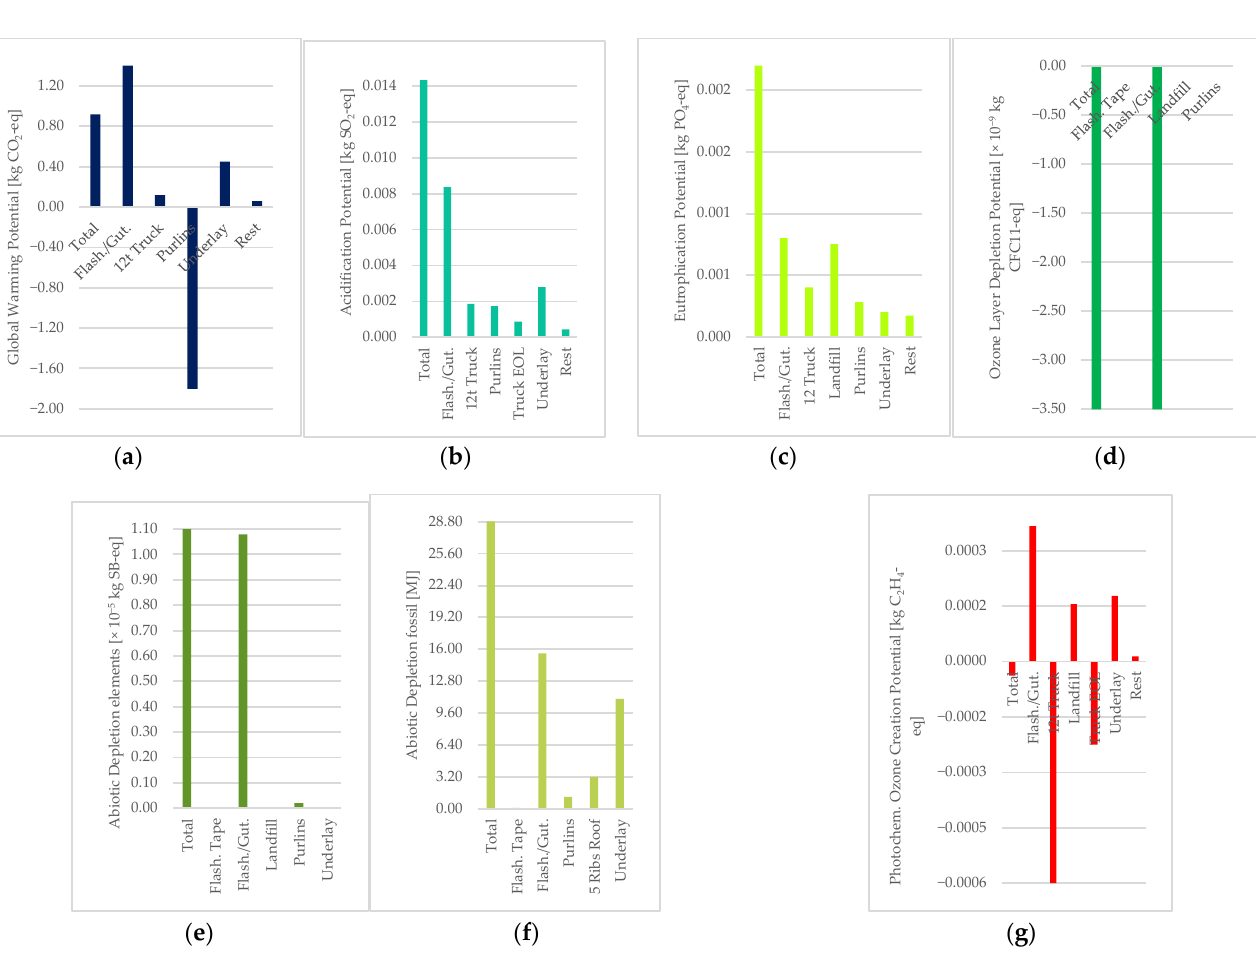
Figure 7. Outputs from GaBi showing the environmental impacts of ancillary items for 1 m 2 of the case study house: ( a ) GWP; ( b ) AP; ( c ) EP; ( d ) ODP; ( e ) ADP elements; ( f ) ADP fossil; ( g ) POCP.